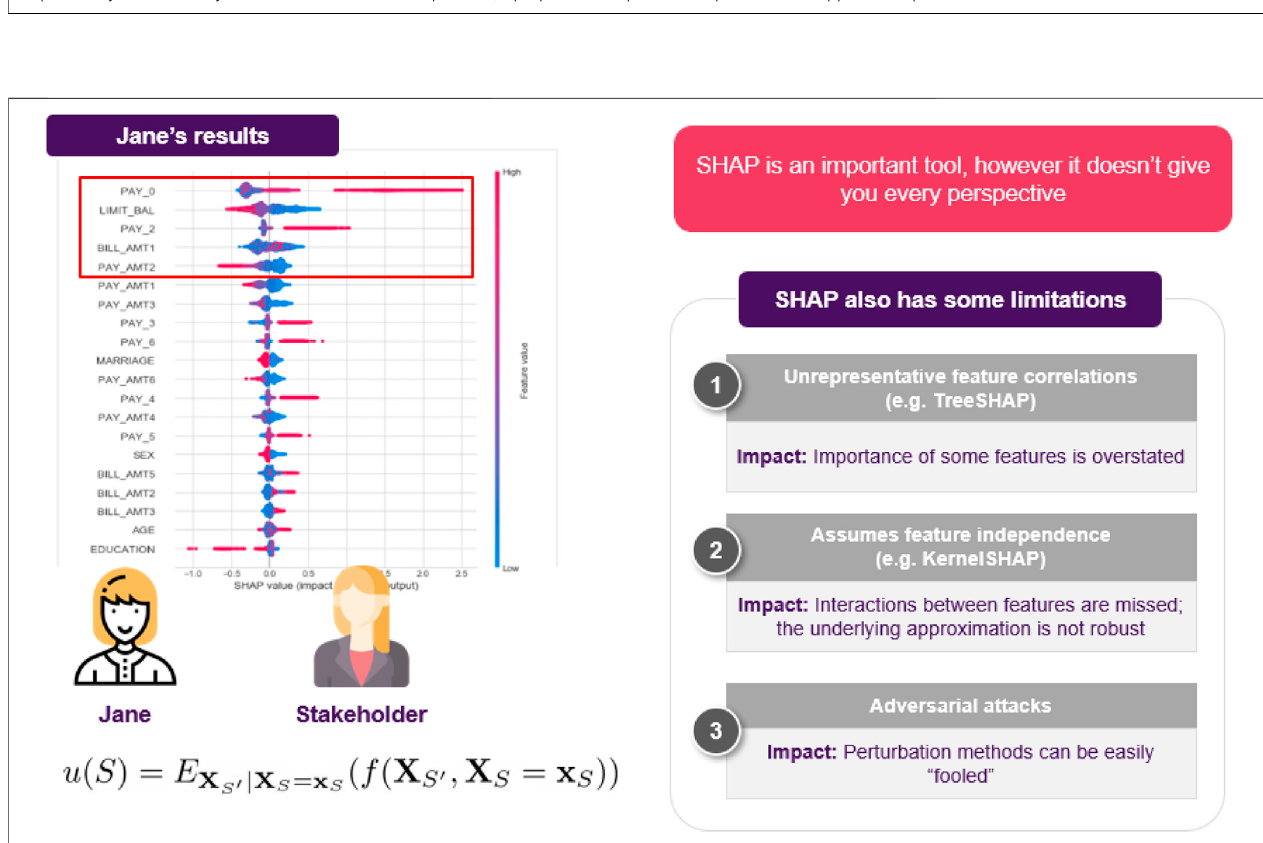
FIGURE 6 | Jane decides to use SHAP, but cannot resolve all of the stakeholder ’ s questions. Its also worth noting that although SHAP is an important method for explaining opaque models, users should be aware of its limitations, often arising from either the optimization objective or the underlying approximation.